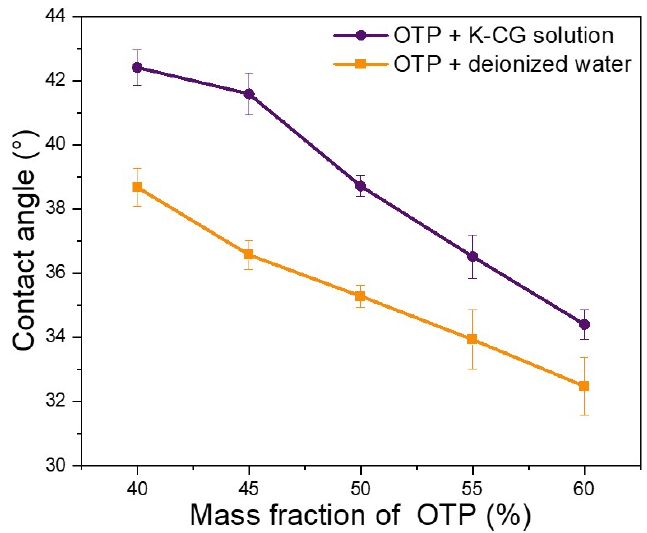
Figure 5. Contact angle in dispersing OTP in water and K-CG solution.